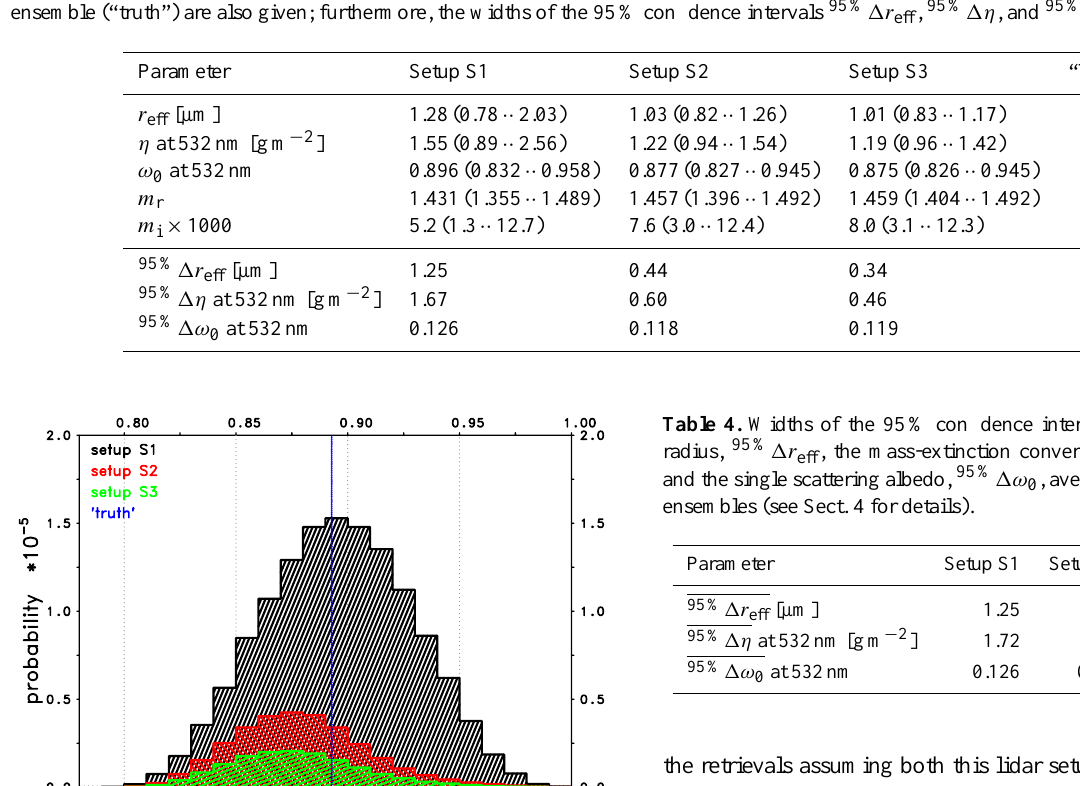
Table 3. Medians and 95% confidence intervals (min ·· max) of the effective radius, r eff , the mass-extinction conversion factor, η , the single scattering albedo, ω 0 , and the refractive index, m , retrieved in Sect. 3 for the three lidar setups; for comparison the parameters of the input ensemble (“truth”) are also given; furthermore, the widths of the 95% confidence intervals 95% (cid:49)r eff , 95% (cid:49)η , and 95% (cid:49)ω 0 are given.